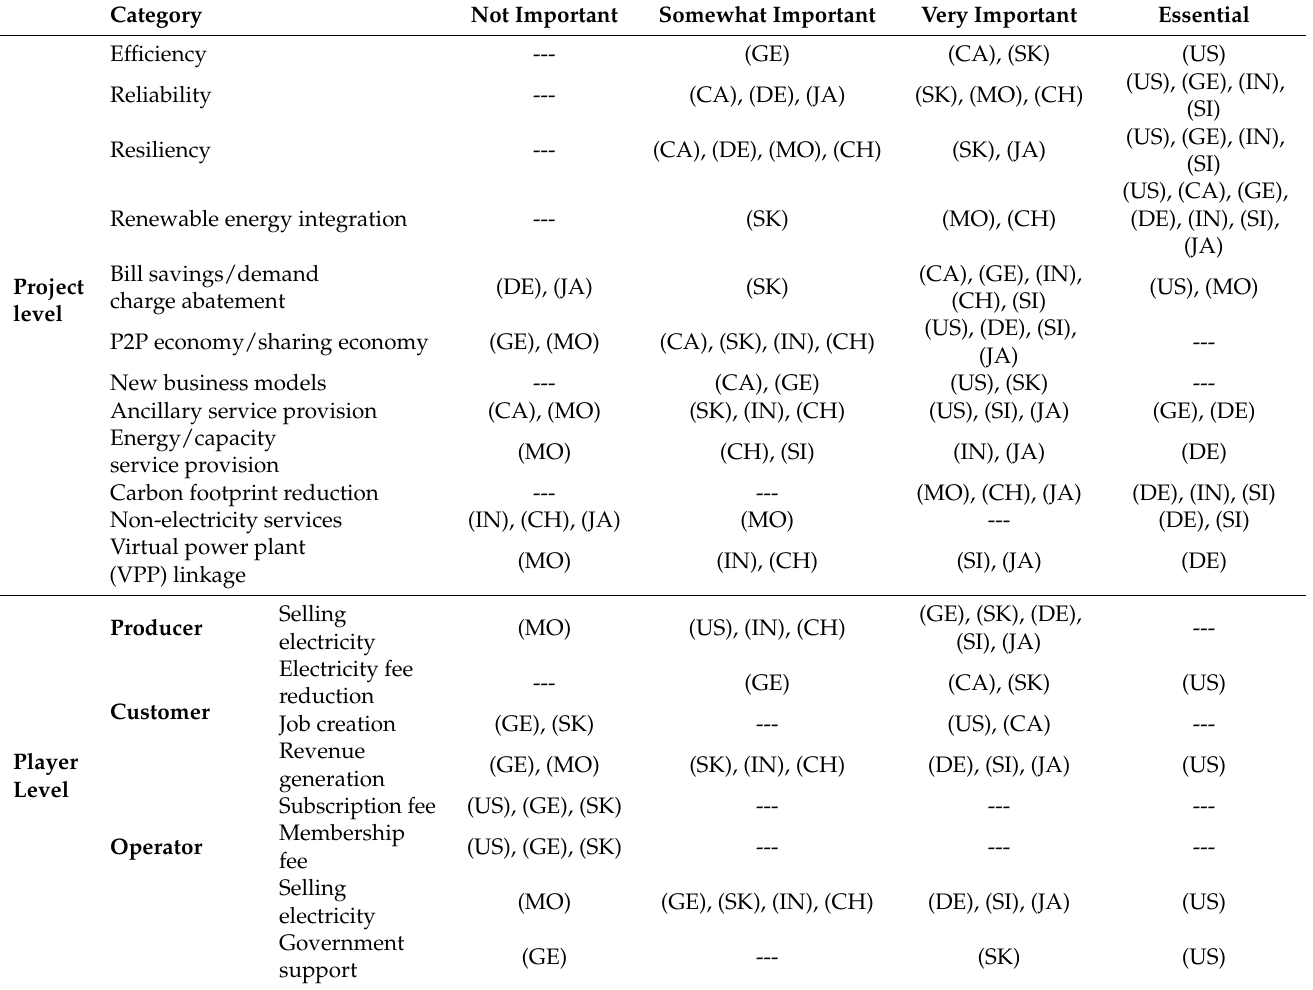
Table 2. Value proposition ranking for different MG projects (based on